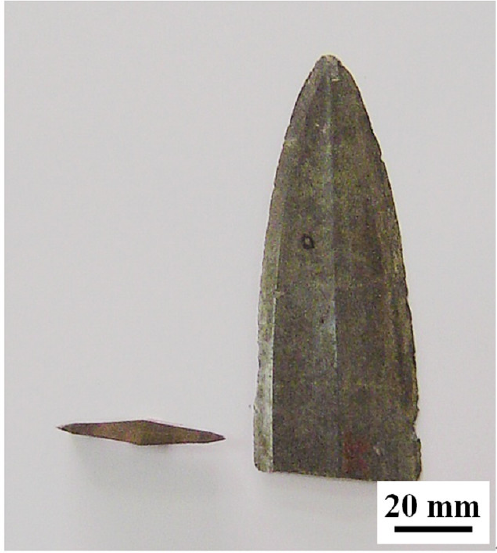
Figure 2. Images of the remnant of the bronze sword.